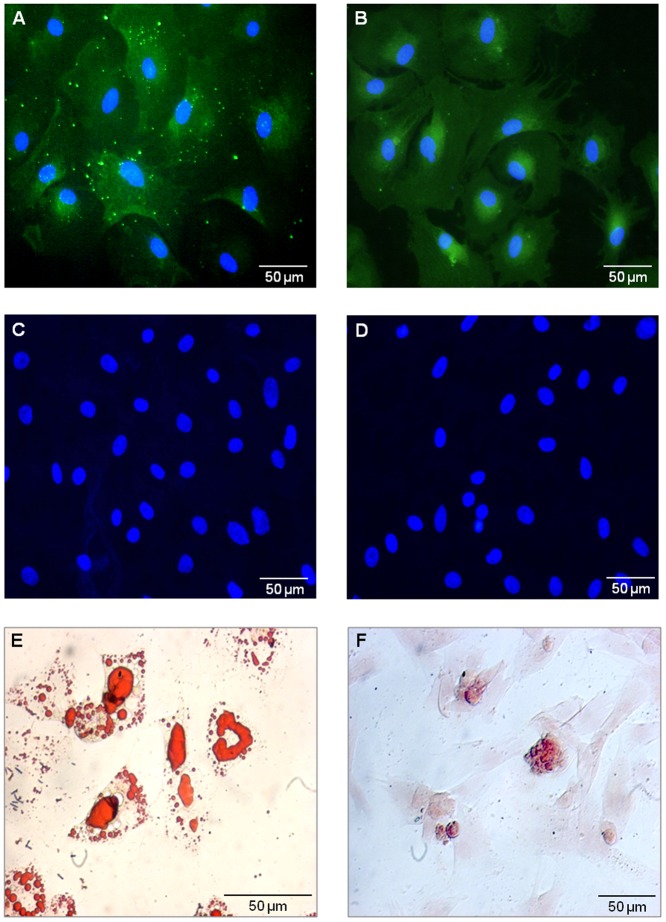
BMSC characterization.P4 BMSCs in vitro are immunostained for (A) CD90 and (B) CD271 (p75NGFr), but are negative for (C) CD45 and (D) CD11b. Nuclei are labelled with Vectashield-DAPI mounting medium. (E) Adipogenic differentiation of P4 BMSC revealed with Oil Red O and (F) osteocyte differentiation revealed by Alizarin Red S.